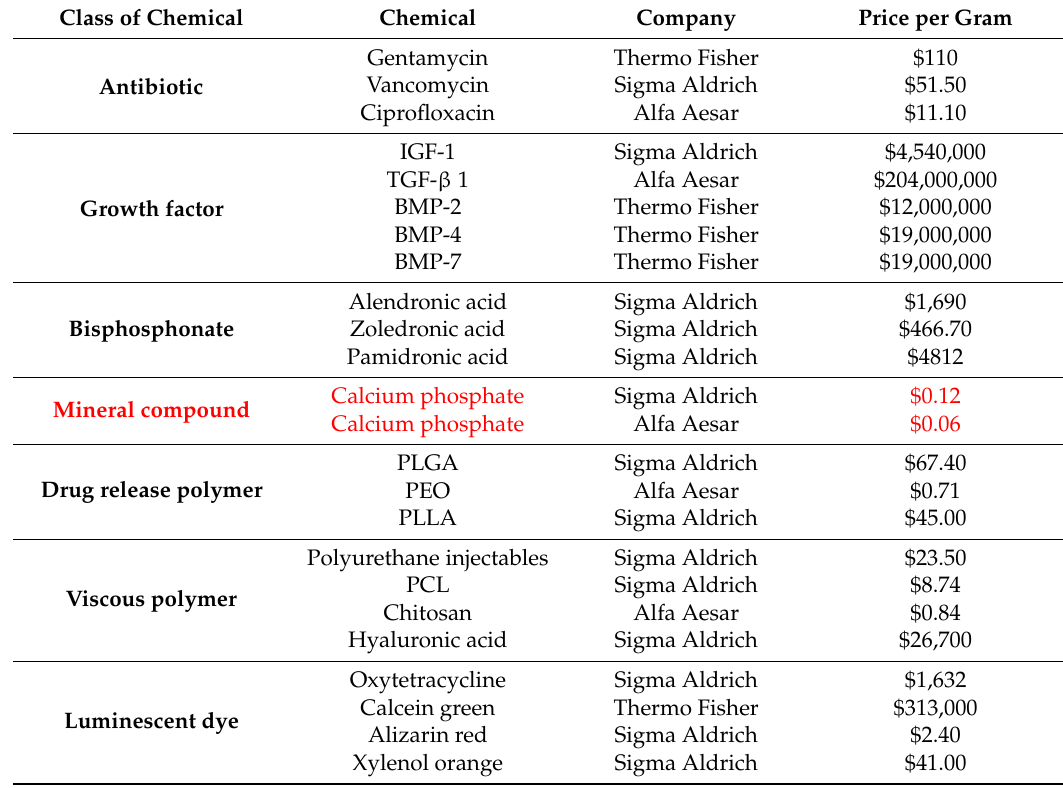
Table 1. The prices for commercially available chemical components of advanced bone graft formulations, listed together with companies producing them. By far the cheapest of them calcium phosphates (CAPs), are colored in red. Prices are given for raw compounds and do not include the cost of processing into forms tailored for specific medical applications, e.g., microspheres, macroporous constructs,